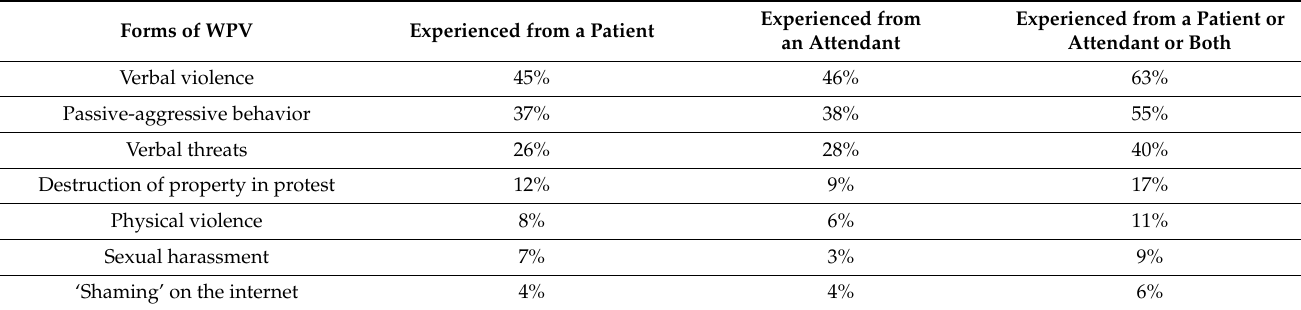
Table 2. Exposure to various forms of workplace